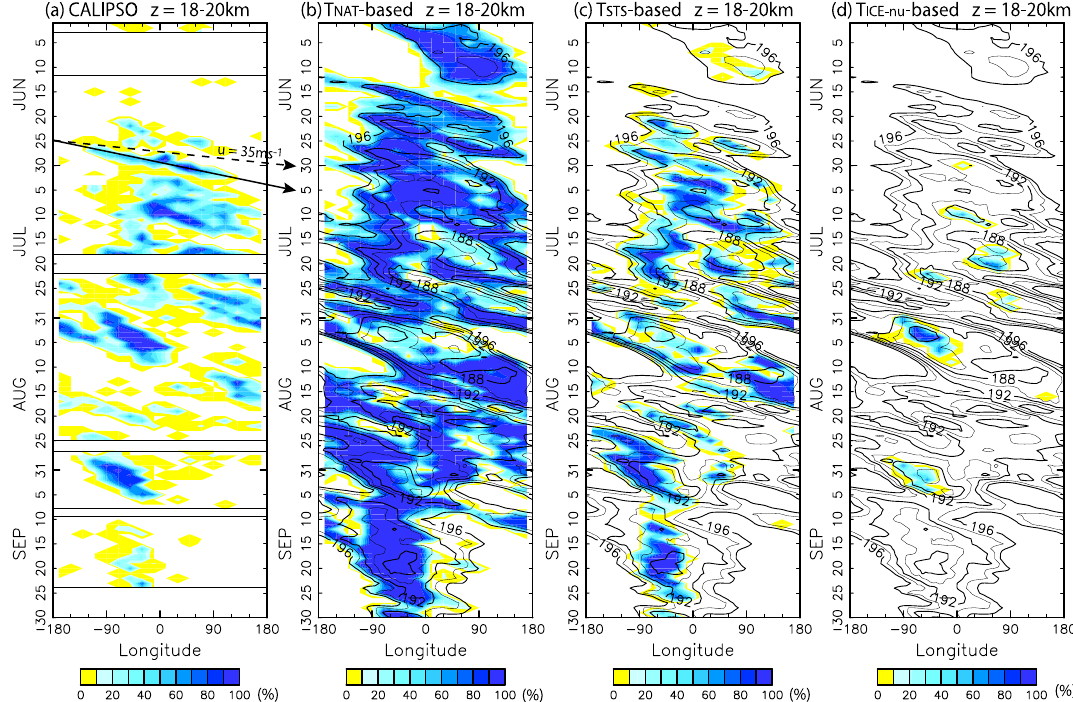
Fig. 3. (a) Hovm¨oller diagram of PSC frequency from CALIPSO observations in austral winter of 2008 averaged within an altitude range of 18–20km in the latitude range of 65 ◦ S–70 ◦ S. Time periods surrounded by black solid lines denote time periods when CALIPSO data are missing. A solid arrow shows the zonal velocity (20ms − 1 ) of high F regions. A dashed arrow shows zonal-mean zonal wind speed (35ms − 1 ) . (b) The same as (a) but for the F estimates based on T NAT as a temperature threshold. Contour lines show temperatures at 50hPa from ERA-Interim data at an interval of 2K. (c) and (d) The same as (b) but for T STS and T ICE - nu as temperature thresholds,